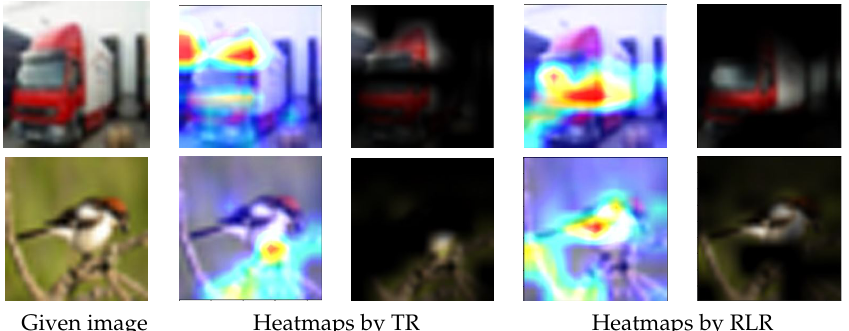
Figure 16. Data augmentation techniques evaluation by saliency map. Column 1: given images; columns 2 and 3: two types of saliency maps for TR; columns 4 and 5: two types of saliency maps